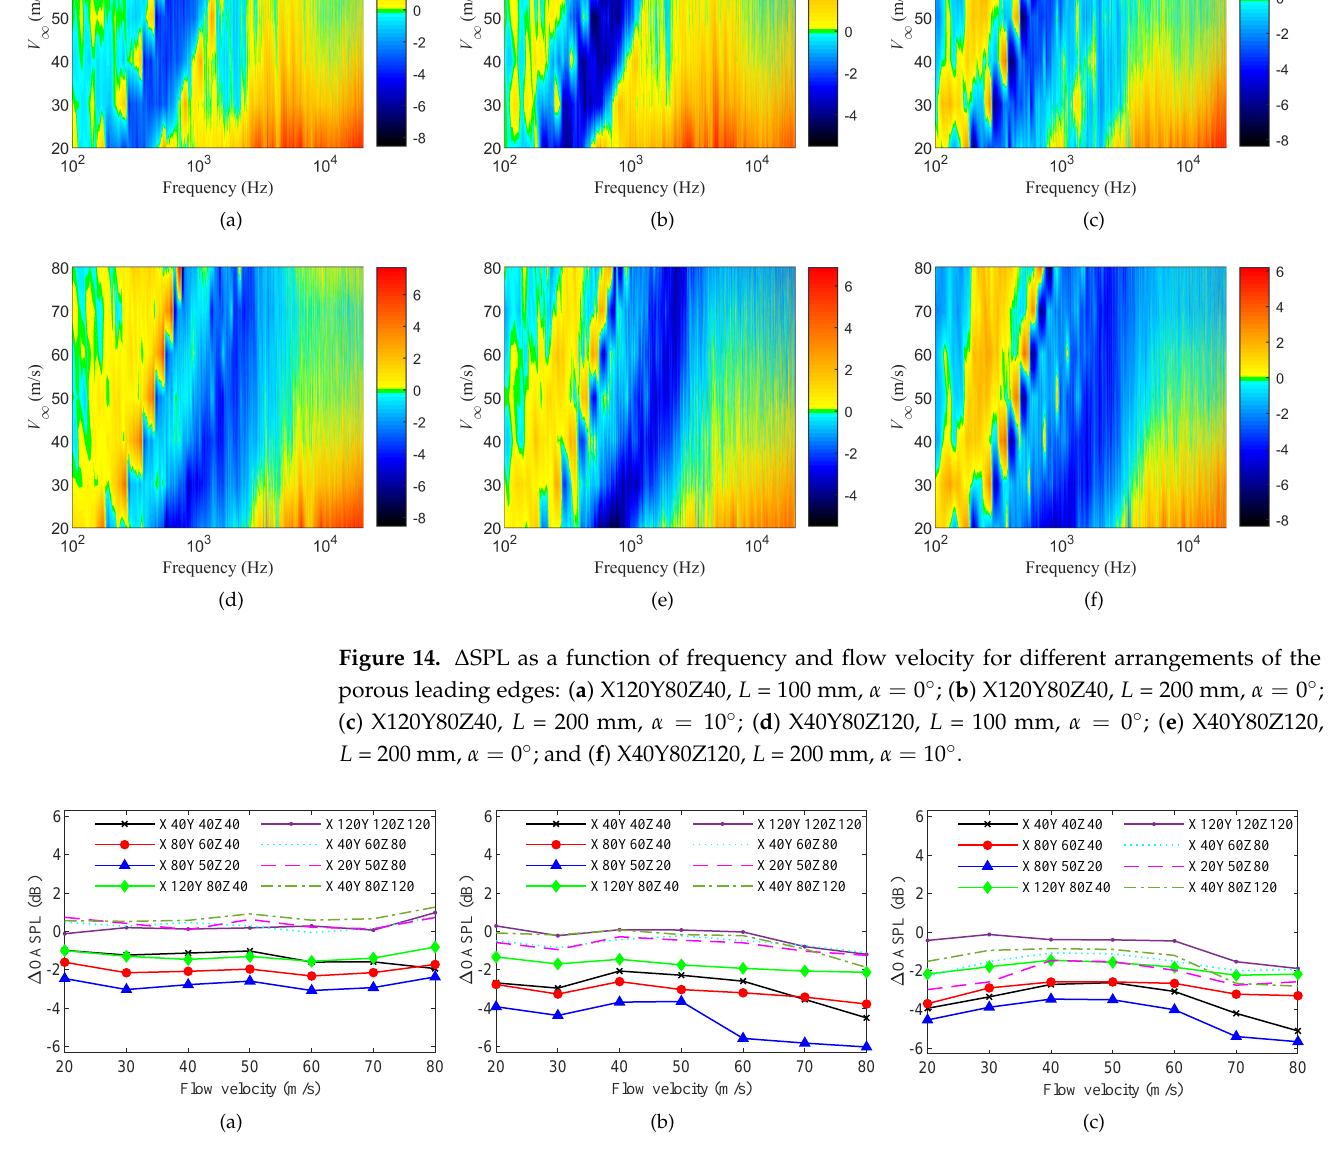
Figure 15. ∆ OASPL for different porous leading edges: ( a ) L = 100 mm, α = 0 ◦ ; ( b ) L = 200 mm, α = 0 ◦ ; and ( c ) L = 200 mm, α = 10 ◦